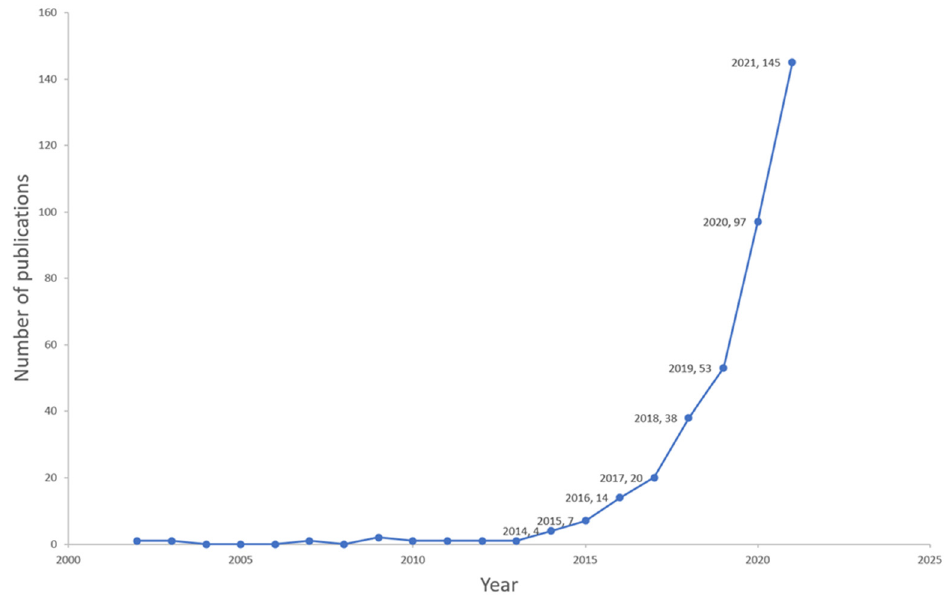
Figure 2. Year-wise distribution of the documents between 2002–2021. Table 1. Top 10 most cited articles on microbiome–gut–brain axis and dementia related